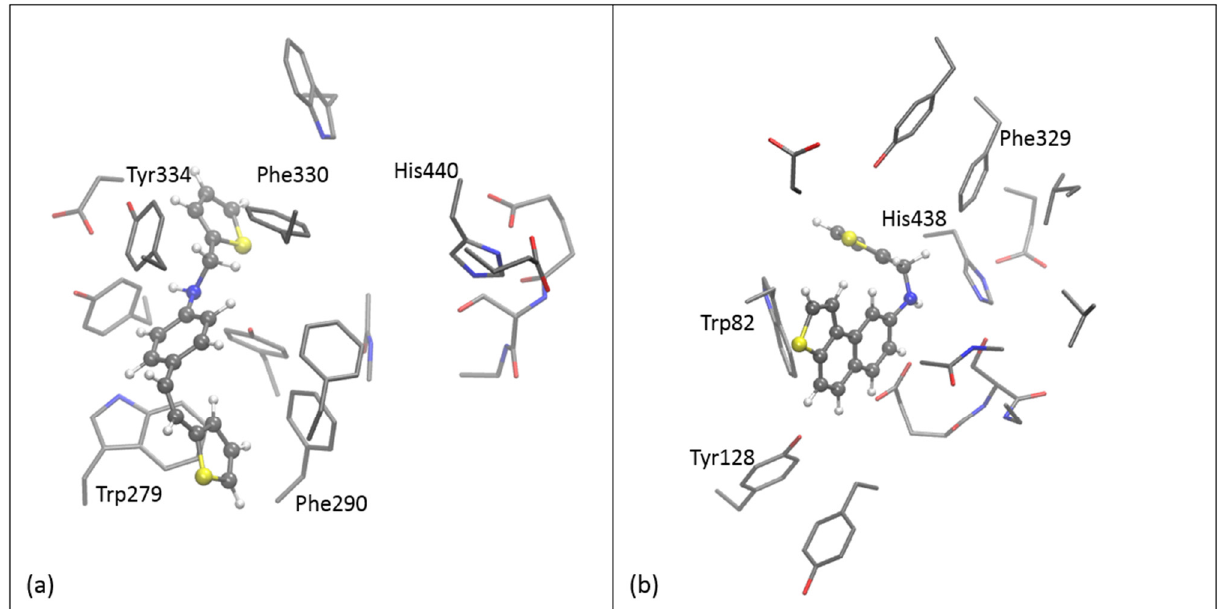
Figure 12. The optimized complexes between the active sites of cholinesterases and tested ligands: ( a ) compound cis - 8 and AChE, and ( b ) compound 15 and BChE.